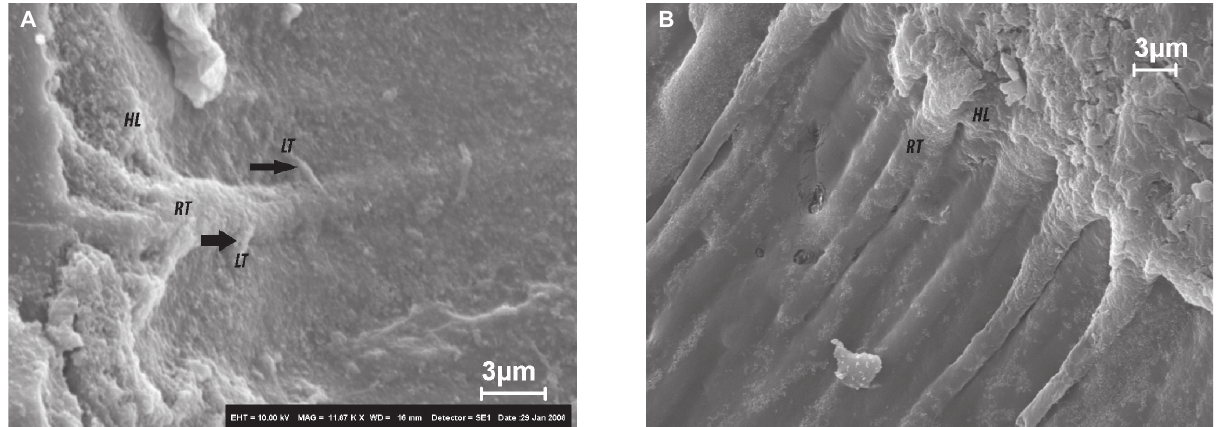
Figure 2- SEM images of dentin-adhesive interfaces. A - Hibrid layer (HL) formed in dentin after use of XP Bond (Dentsply) two-step etch-and-rinse system. Elongated, funnel-shaped resin tags (RT) can be seen due to the demineralization produced !"#$%&#$%'()"*)(+",-)$(./0"1*-,'*2"-3 32,&"415"*.+" 2*)6"*''%7&8"7,',"*2&%"922,+"7(-$"',&(.:"(;#%'-*.-"&-'3)-3',&"(."-$," adhesive mechanism. B - This SEM image was obtained using All Bond 3 (Bisco) three-step etch-and-rinse system. It is also possible to see the hybrid layer (HL) and long, funnel shaped resin tags (RT)